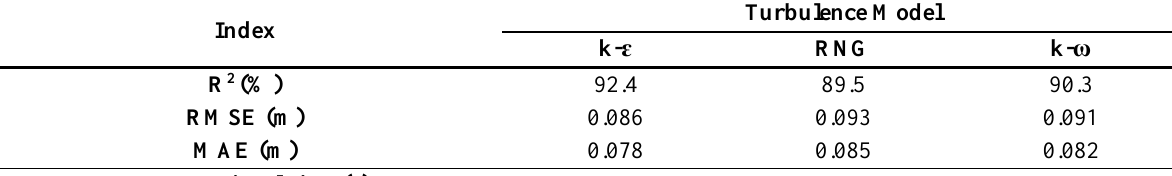
Turbulence models assessment.